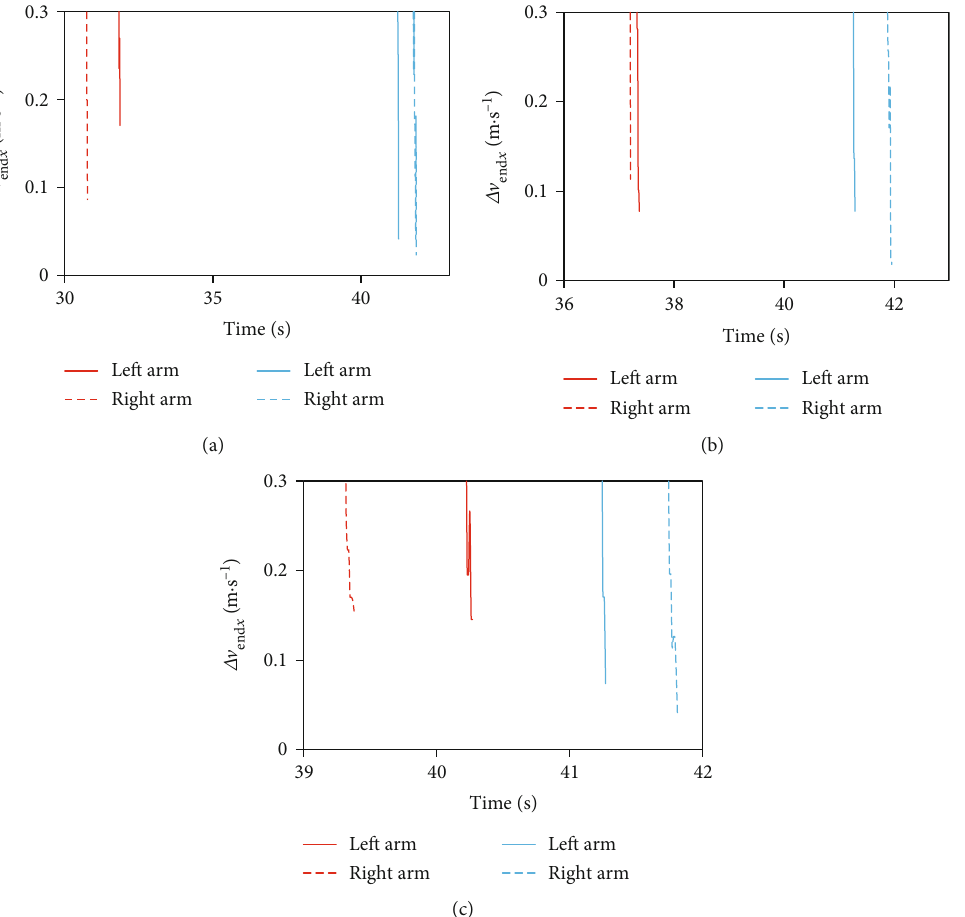
Figure 13: Vertical velocities of both the left and right manipulator end e ff ectors relative to the desired capture points. The solid lines represent the left manipulator, and the dotted lines denote the right manipulator. The red lines denote the chaser controlled by the traditional control strategy, and blue lines denote the chaser controlled by the networks. All the lines are terminated when the manipulators hit the target. (a) Case 4. (b) Case 5. (c) Case